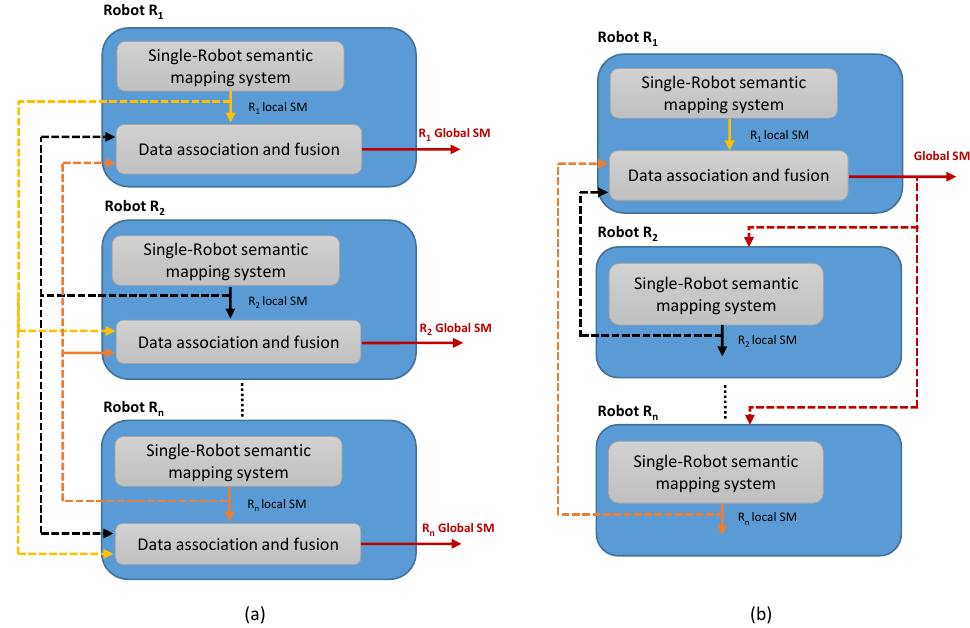
Figure 7. Representation of the distribution of a semantic-mapping system in a distributed architec- ture. ( a ) Each robot collects data from neighboring robots and establishes data association and fusion to create its global semantic map, ( b ) a single robot collects maps from neighboring robots, creates the global semantic map and distributes it to other